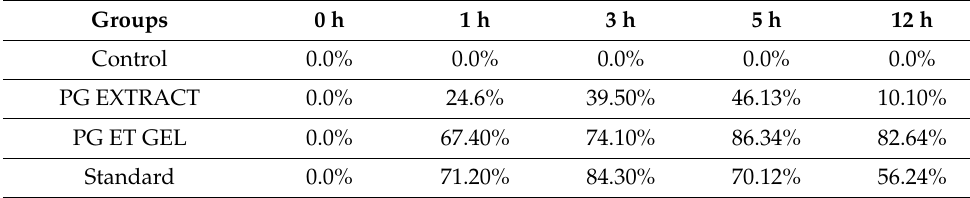
Figure 11. Percent inhibition values of P. granatum extract, ethosomal gel, and standard. Table 6. Anti-inflammatory activity of different samples on percentage inhibition of